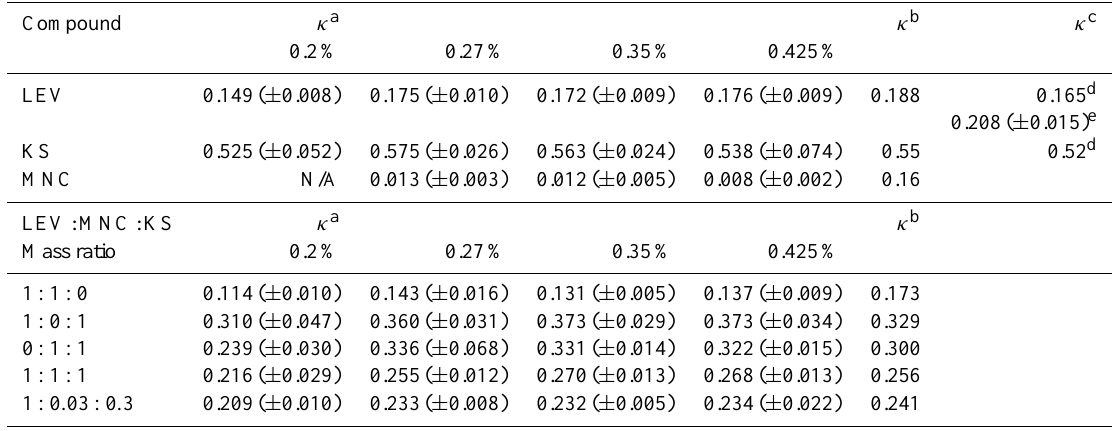
Table 2. Tabulated experimentally derived hygroscopicity parameters, κ , for the various particle types investigated in this study before oxidation.